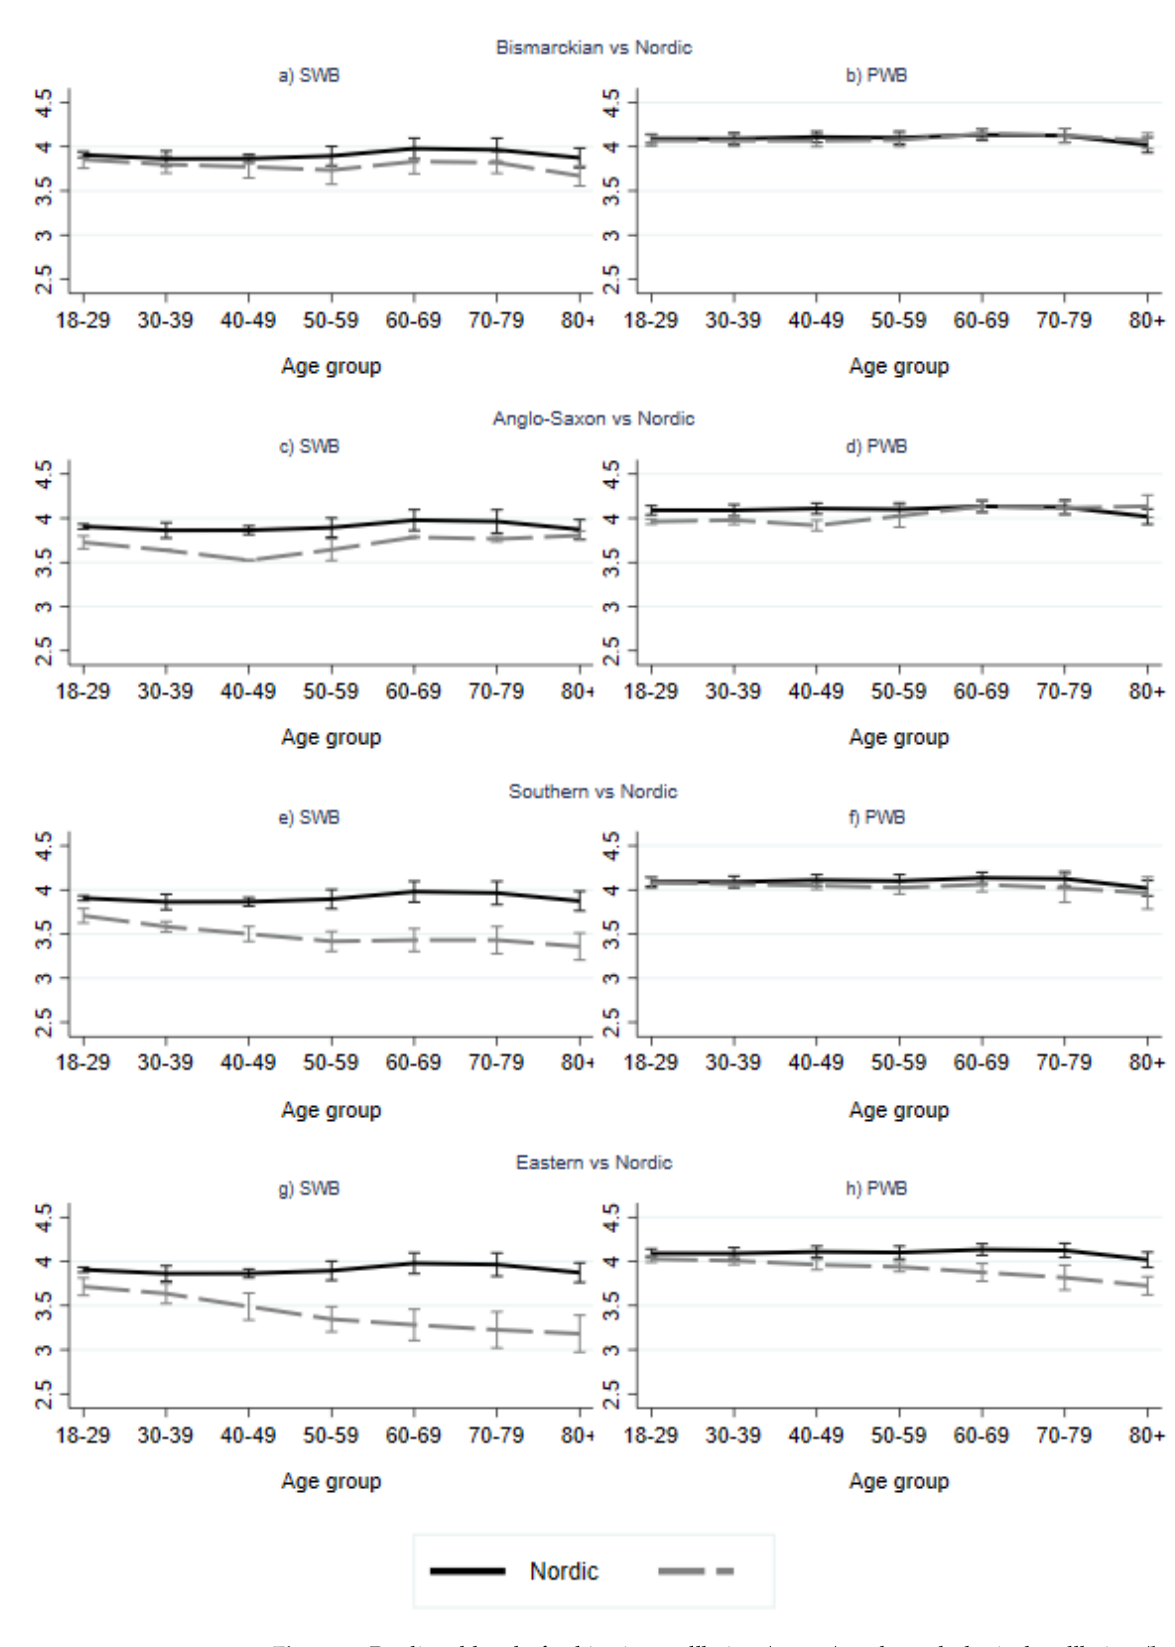
Figure 5. Predicted level of subjective wellbeing ( a , c , e , g ) and psychological wellbeing ( b , d , f , h ) by age and WS regime type (Bismarckian ( a , b ), Anglo-Saxon ( c , d ), Southern ( e , f ) and Eastern ( g , h )). Nordic is reference group. Results from multilevel regression (Model 3). NB Scale in Figure 2.5 – 4.5.